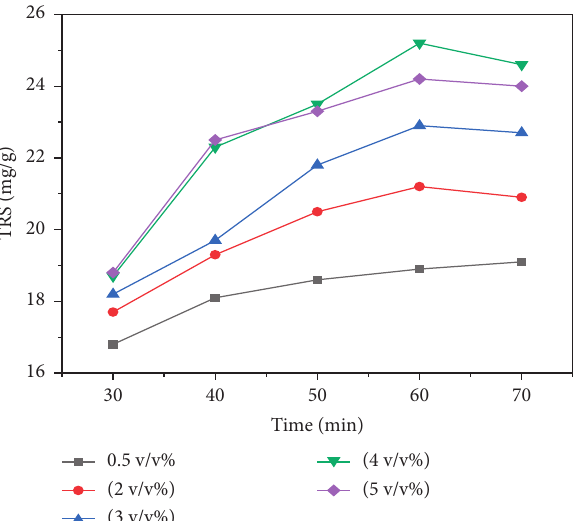
Figure 5: The effect of hydrolysis time and dilute sulfuric acid concentration on the yield of total reducing sugar (TRS) from Teff straw (hydrolysis temperature � 120 ° C and solid to liquid ratio �